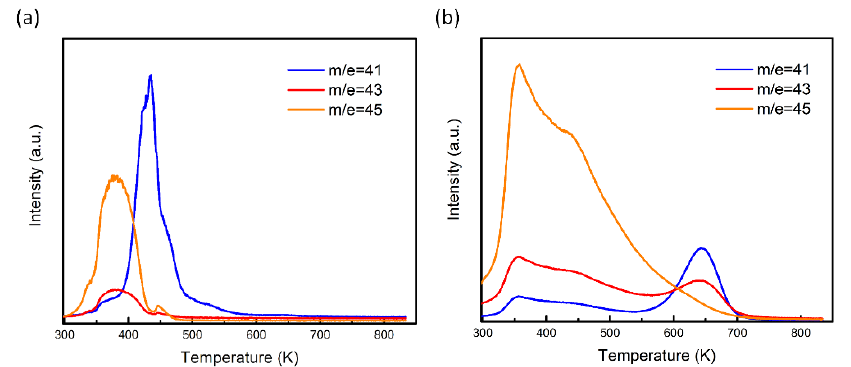
Figure 3. TPD of 2-propanol from ( a ) bare Al 2 O 3 ; ( b ) Al 2 O 3 loaded with 18 wt% CaTiO 3 . Desorption features correspond to propene (m/e = 41), acetone (m/e = 43), and unreacted 2-propanol (m/e = 41, 43, and 45) .